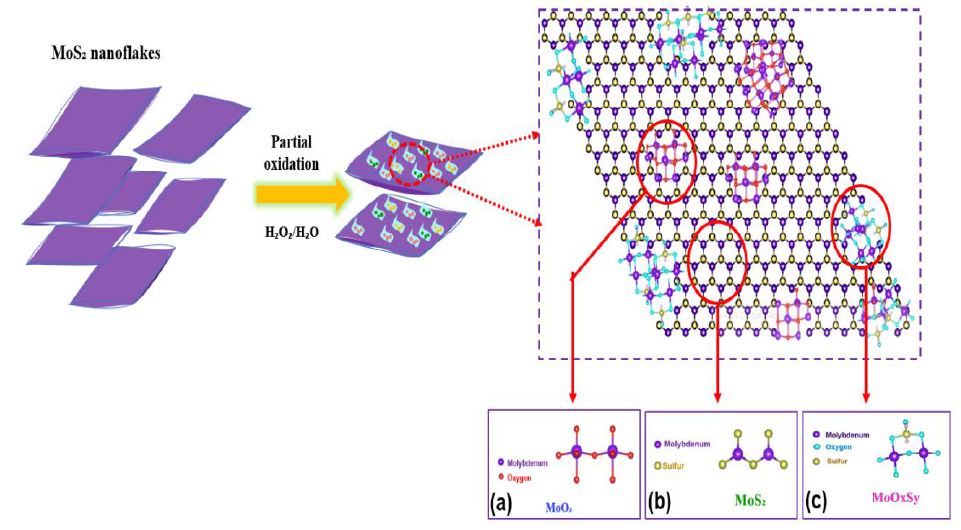
Figure 9. Illustration of the hybrid MoO 3 :MoS 2 synthetic process, and the chemicals structure of ( a ) MoO 3 ( b ) MoS 2 and ( c ) MoOxSy.